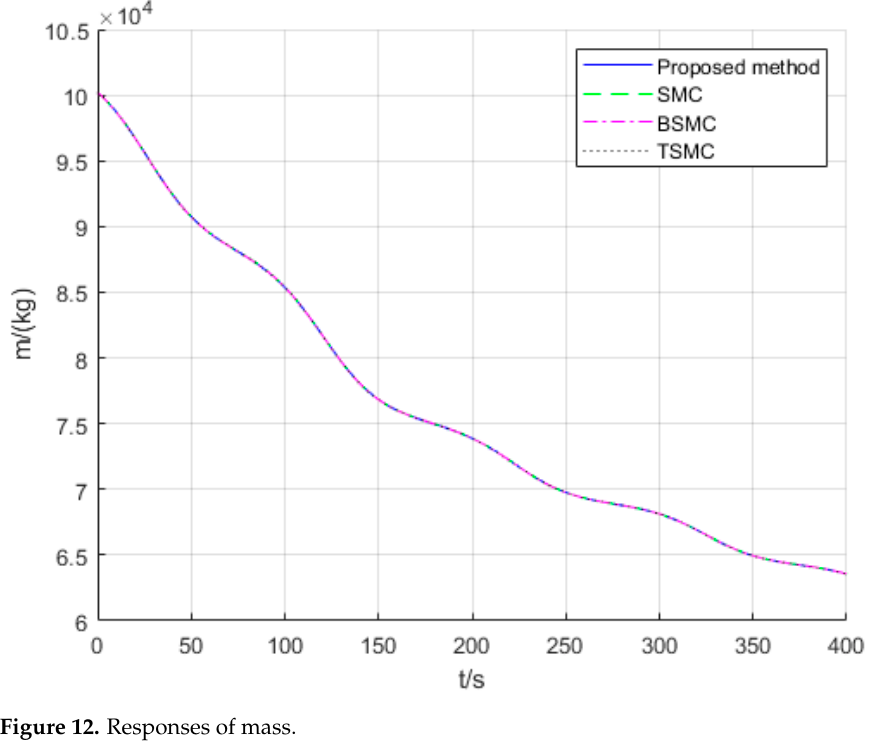
Figure 11. Responses of pitch angle rate.